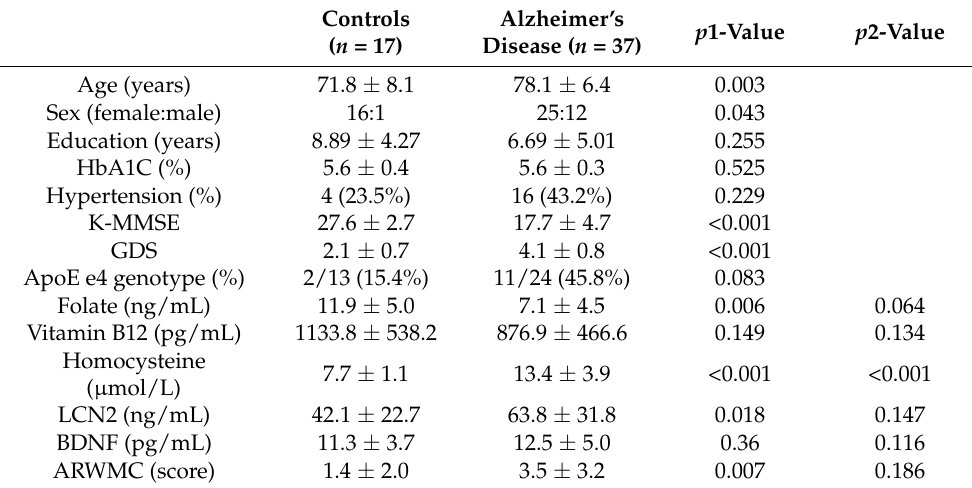
Table 1. Characteristics of control and Alzheimer’s disease